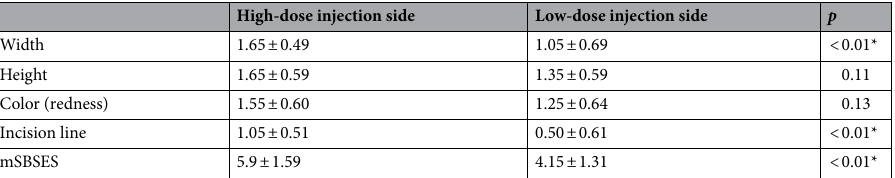
Table 2. Modified Stony Brook scar evaluation scale (mSBSES) of the high-dose and low-dose injection sides at 6 months after BTxA injection. *Significant different. Data is represented as mean ± standard deviation (M ± SD).